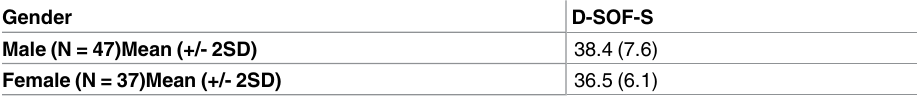
Table 3. Normative values of distance between the superior orbital fissure and the substantianigra (D-SOF-S) stratified for